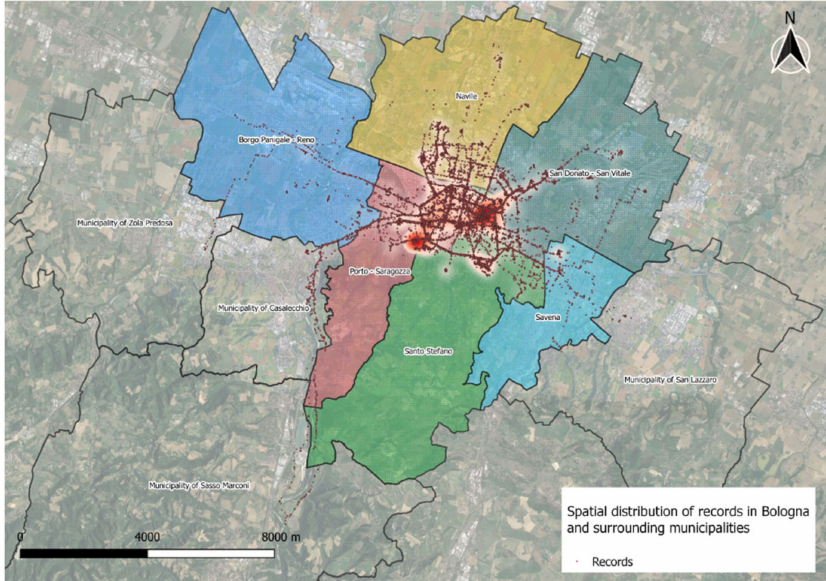
Figure 5. Spatial distribution of records (points and heatmap) in Bologna and surrounding